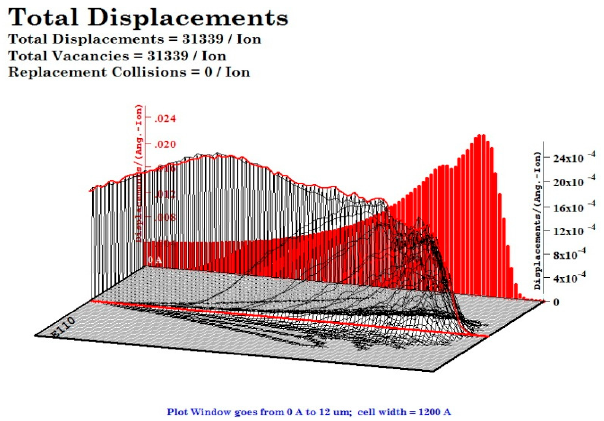
Figure 14. Damage caused by 120 MeV Pd in E110 alloy.